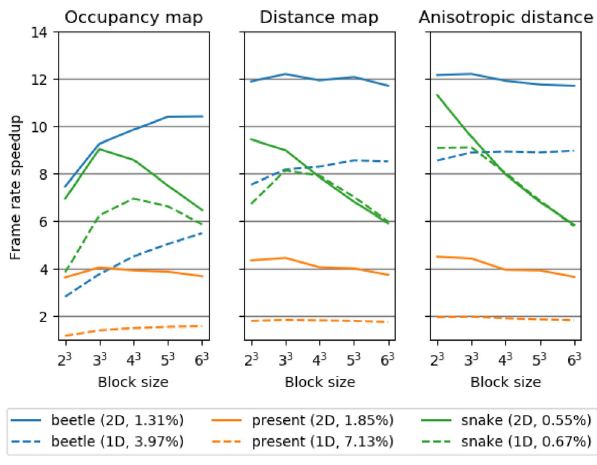
Fig. 3 Relative frame rate speedup from unaccelerated baseline for each acceleration structure with our ray traversal approach.